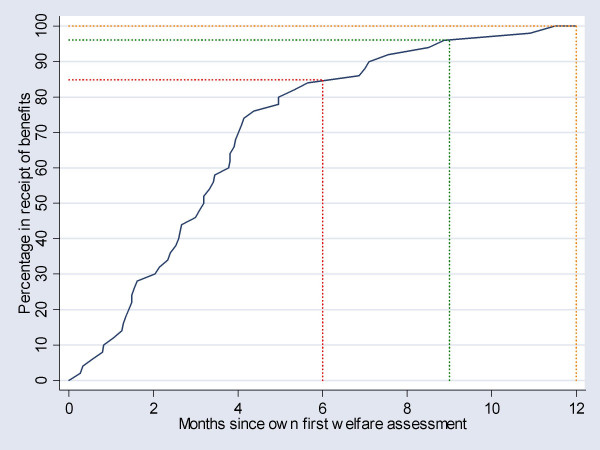
Time from own first assessment to receiving financial benefits in intervention and control groups combined.